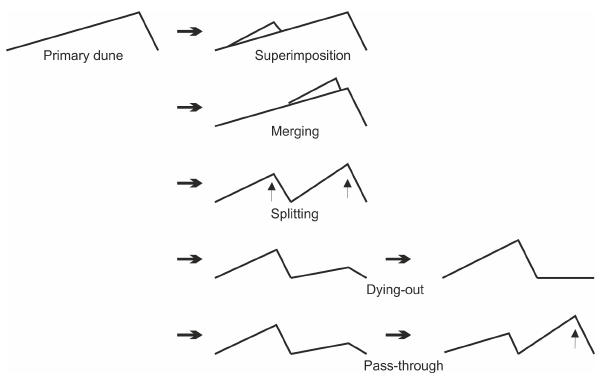
Figure 1. Illustration of the five dune creation and destruction mechanisms based on the classifications of Gabel (1993) and Martin and Jerolmack